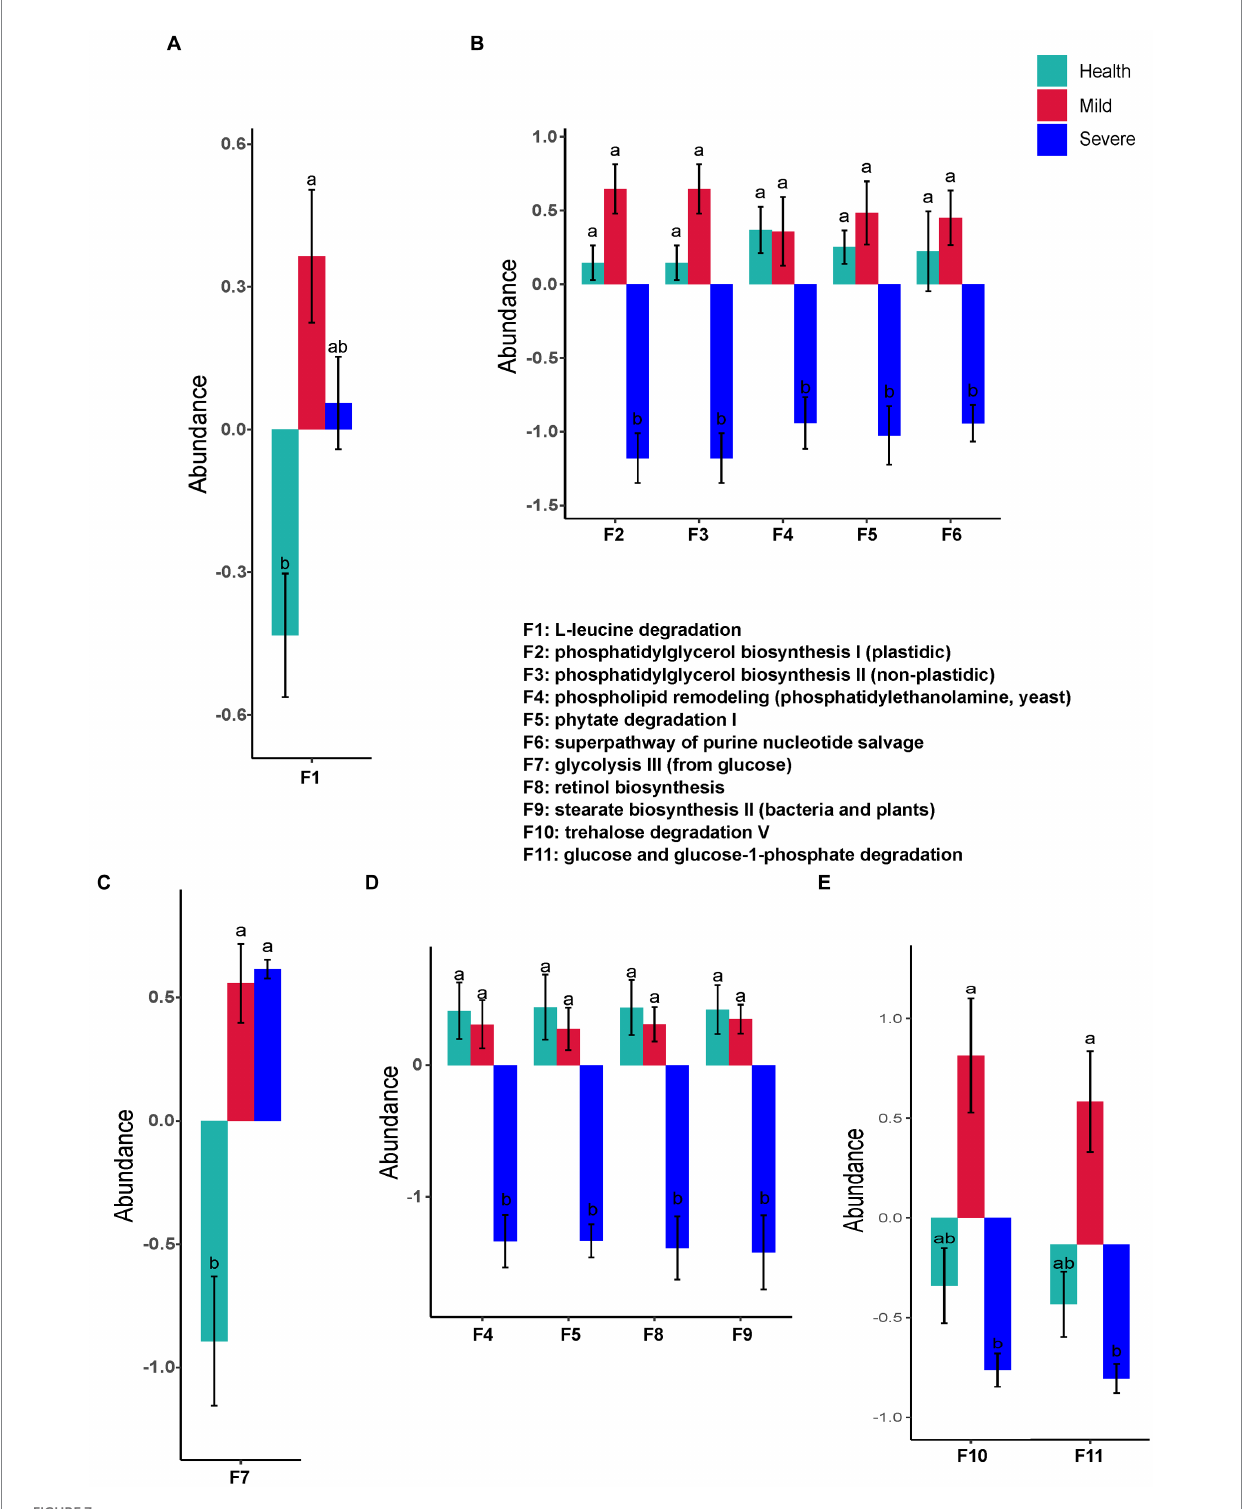
FIGURE 7 The fungal flora predicted functions that had a significant difference between groups. (A) Total samples from all sampling sites; (B) samples from the forehead; (C) samples from the cheek; (D) samples from the chin; (E) samples from check and back. The different alphabet on the column represented there was a significant difference between